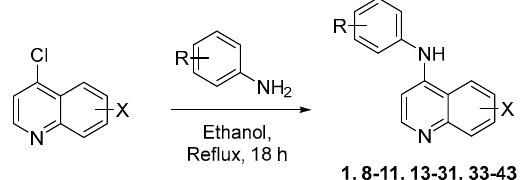
Scheme 1. General displacement synthetic procedure.